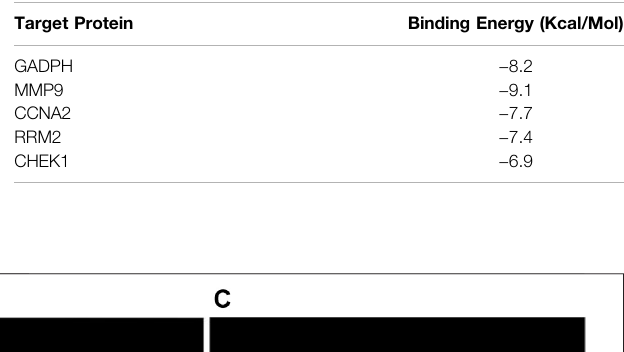
Frontiers in Physiology |